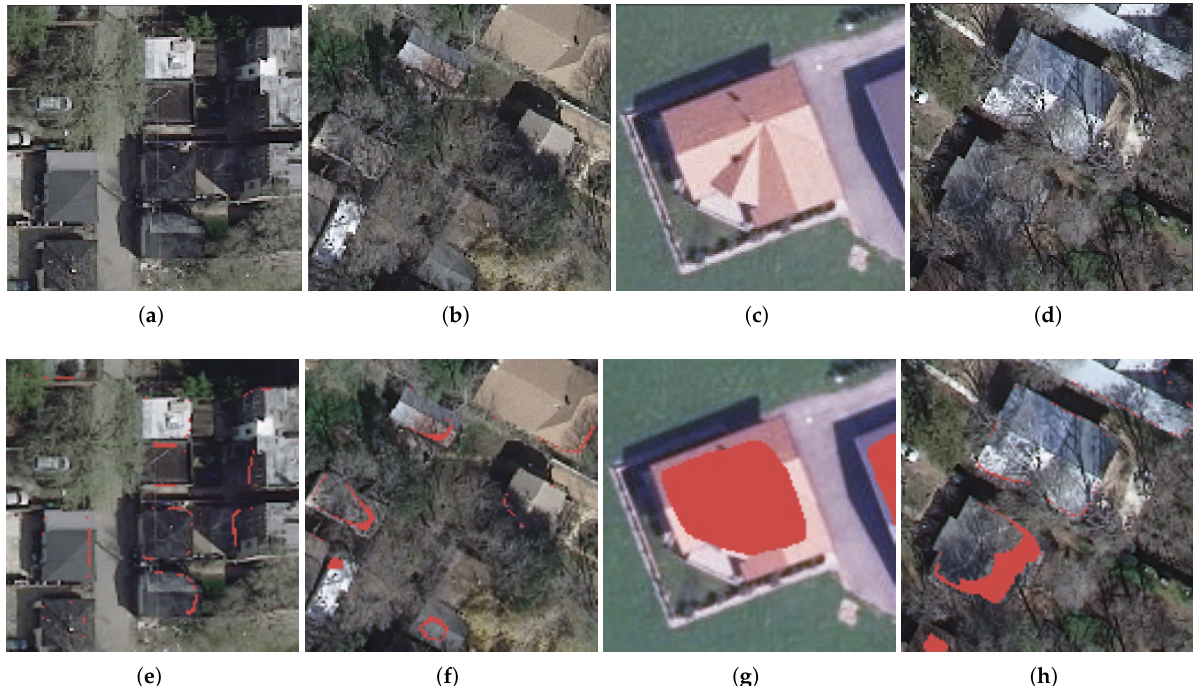
Figure 11. Impacts of the binary geohash. By setting the geohash code to zeros, the impacts of the geospatial information are thoroughly eliminated. After zeroing the geohash codes, the changed labels are marked in a red color. Subfigures of ( a – d ) are samples from the Inria dataset. In the subfigures of ( e , f , h ), the majority of the altered pixels appear on the border of buildings, while some regions of the buildings are radically changed in the subfigure ( g ). All the sample images have a size of 128 128. ×